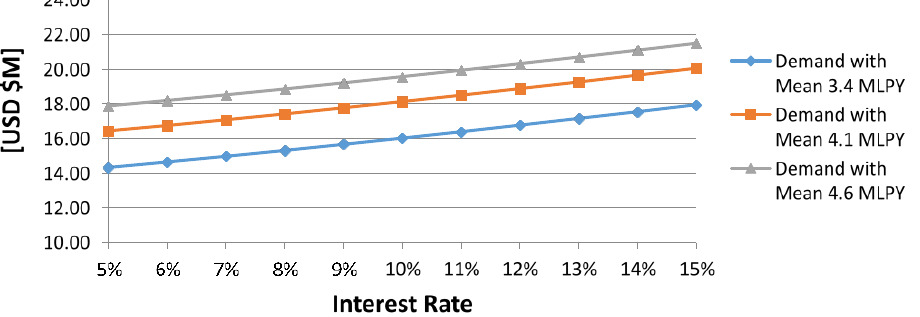
Figure 9. Total cost obtained from different interest rates and customer demands.